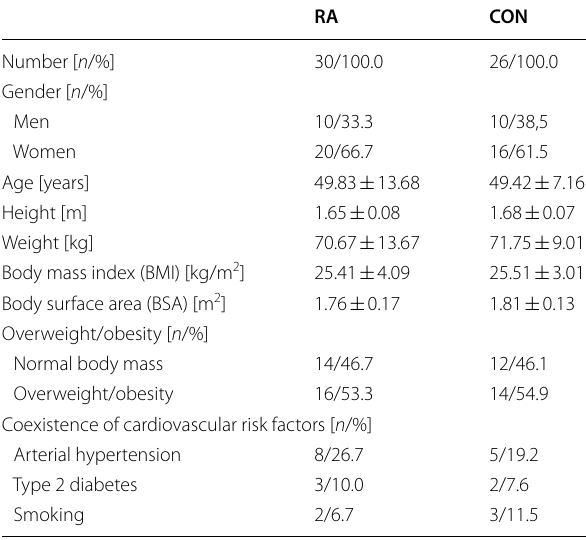
Table 1 General characteristics of the study group of